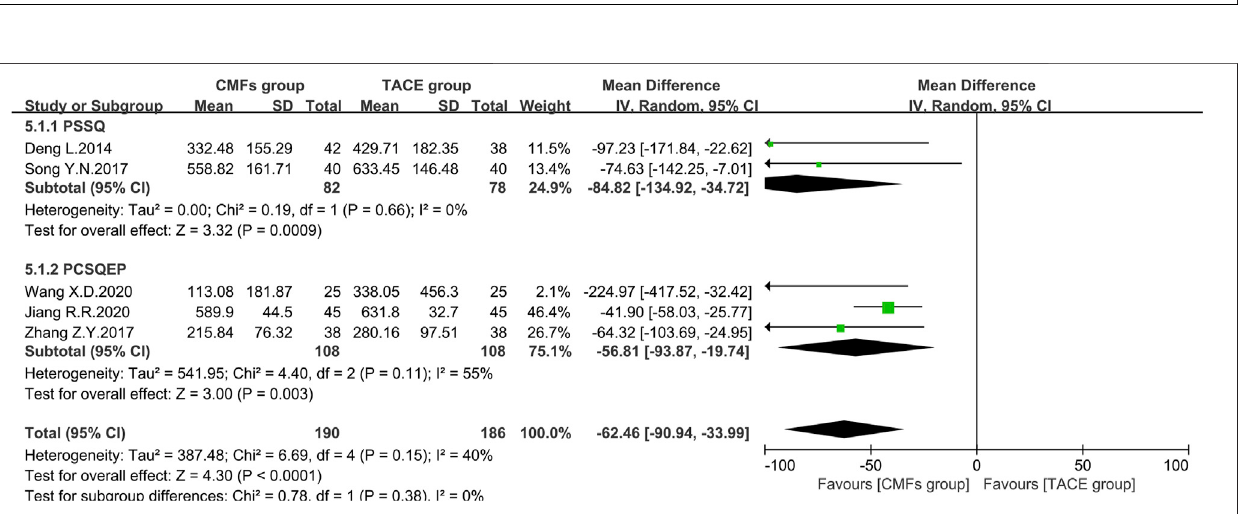
FIGURE 12 | Effect of CMFs group versus TACE group on AFP, including a comparison between PSSQ and PCSQEP in the subgroup.